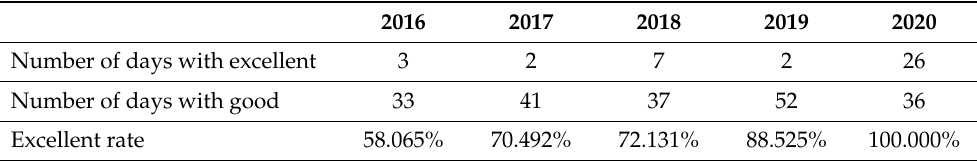
Table 2. Overall air quality excellent rate statistics from 2016 to 2020.